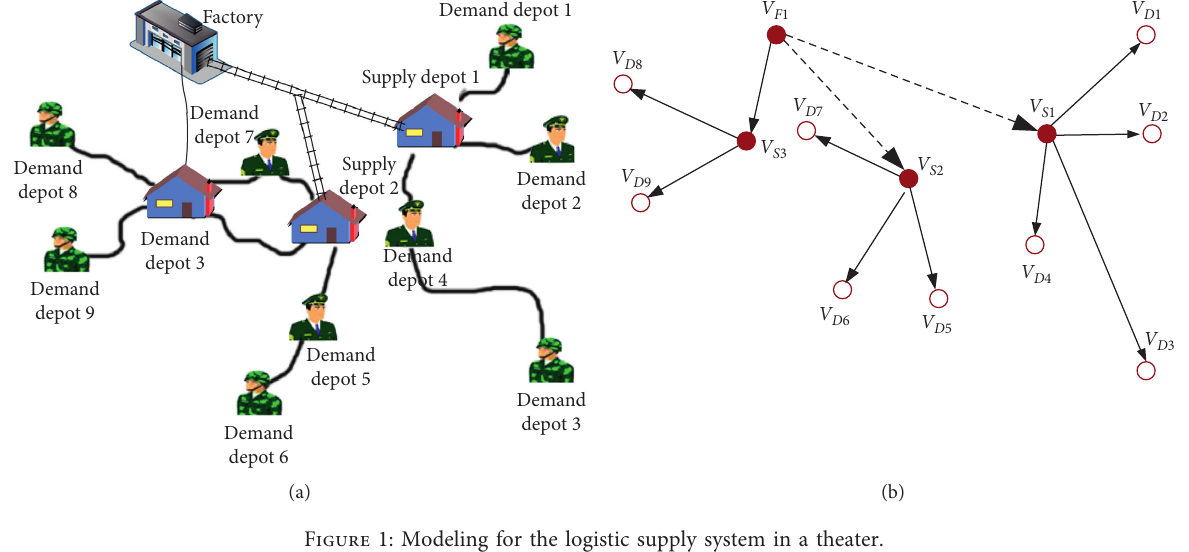
Figure 1: Modeling for the logistic supply system in a